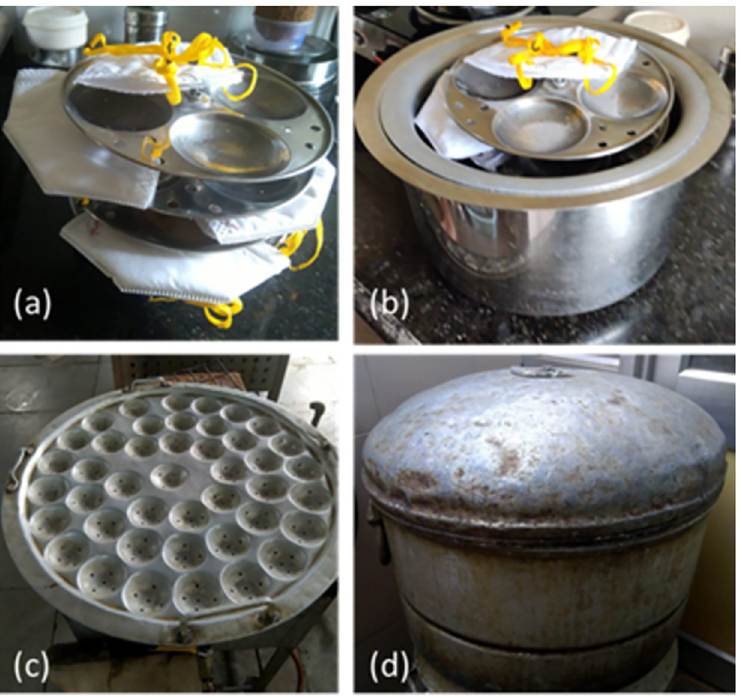
Fig 9. Multiple respirator decontamination possibilities using the boiled hot water technique. (a) 4-stand “idli- cooker” insert used for cycle 6, shown with 4 Venus 4400 respirators. (b) shows the nested vessels (without lids) used for this experiment.